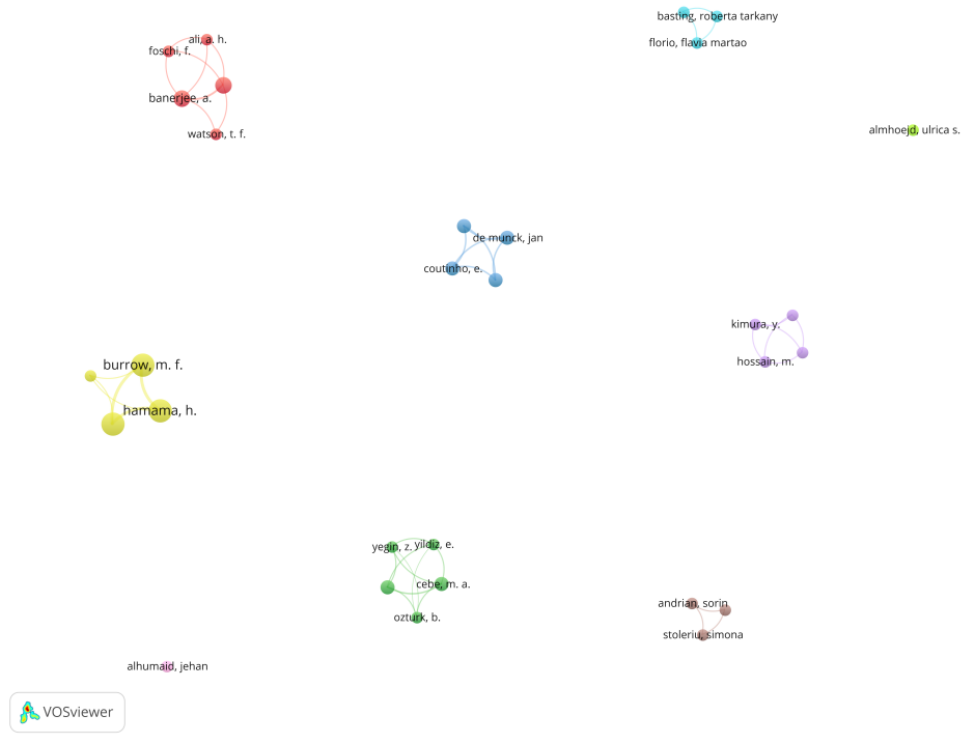
Figure 2. Network of scientific co-authorship, based on the number of documents per author. Source: own processing through VOSviewer. Table 2. Author groups and related number of documents and links. Source: own processing through VOSviewer.